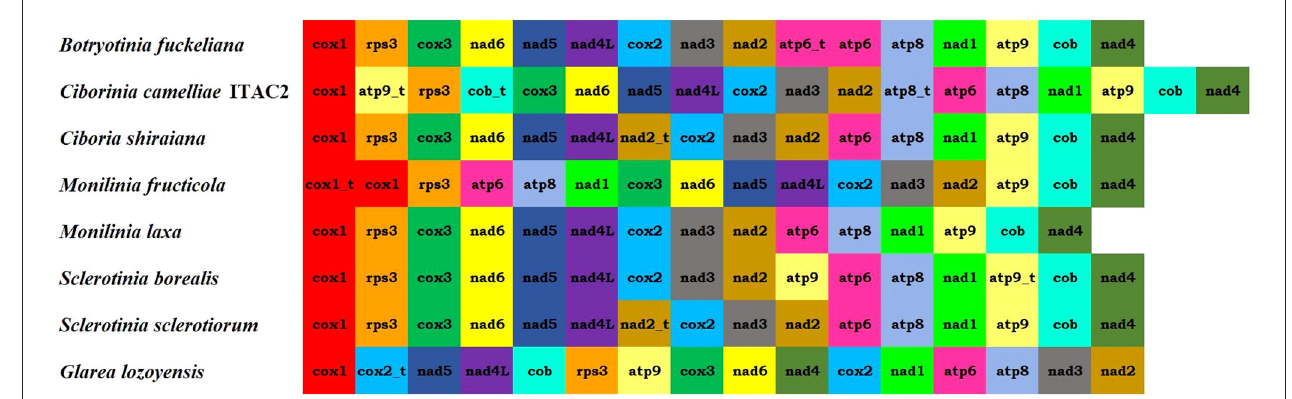
FIGURE 2 | Mitogenome organization of the seven Sclerotiniaceae investigated [ Botryotinia fuckeliana (KC 832409) , Ciboria shiraiana (CM 017871.1) , Ciborinia camelliae strain ITAC2 (OK326902) , Monilinia fructicola (NC_056195.1), Monilinia laxa (NC_051483.1) , Sclerotinia borealis (KJ434027) and Sclerotinia sclerotiorum